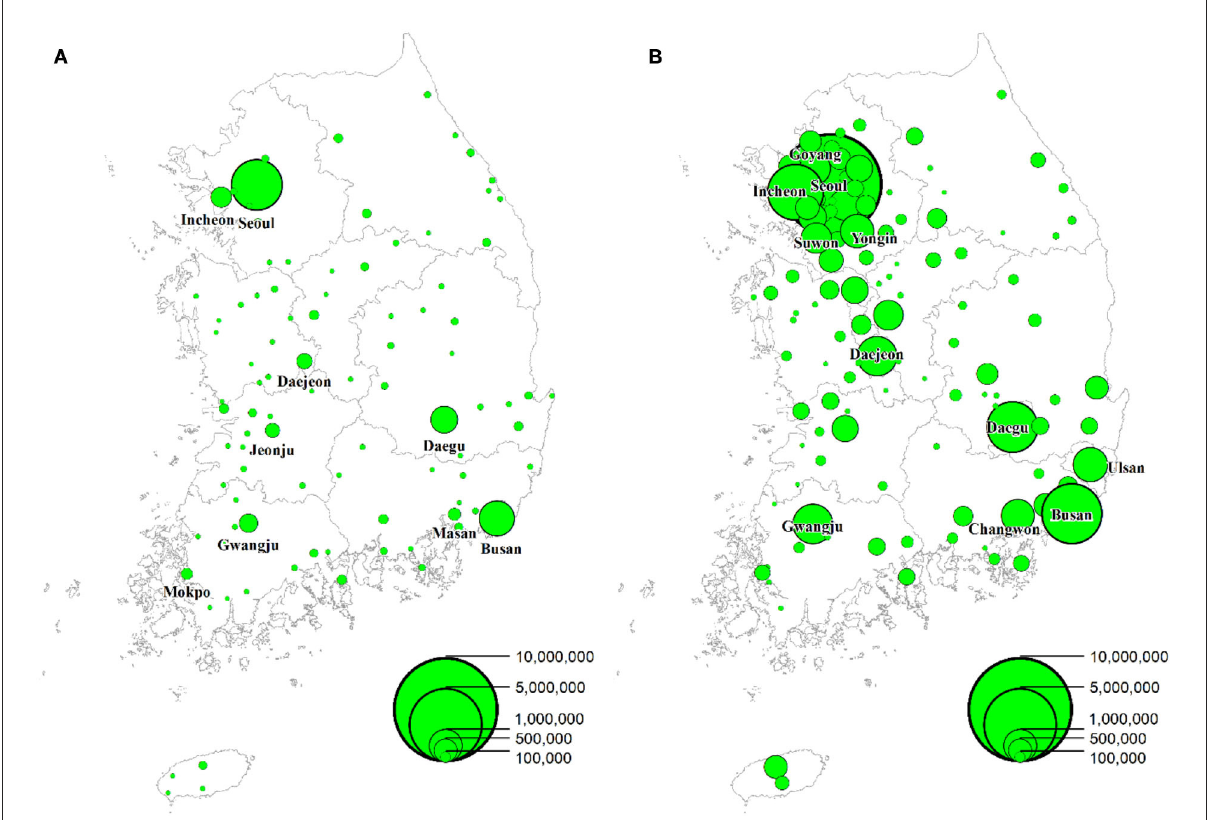
FIGURE2 Population distributions in Korea: (A) 1960 and (B)